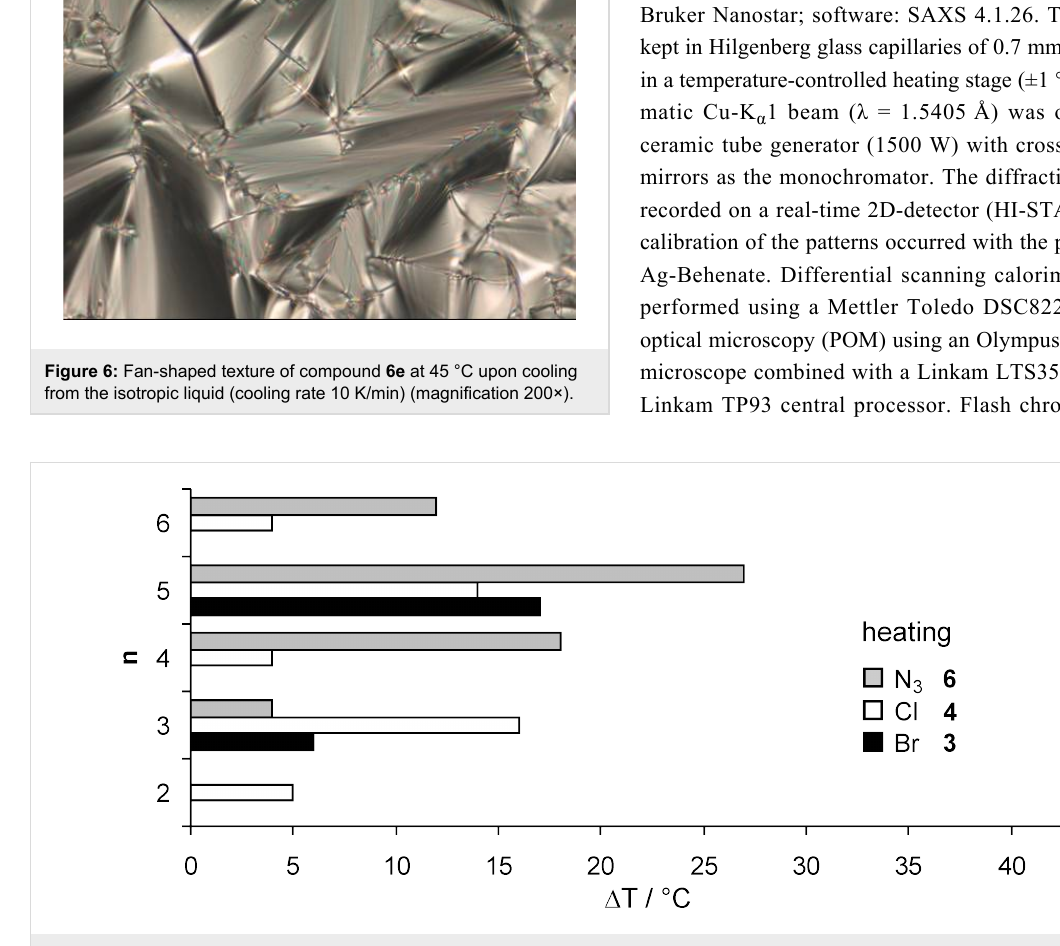
Figure 7: Comparison of the mesophase range Δ T for the different spacer lengths of compounds 3 , 4 and 6 : mesophase range upon heating (heating rate 10 K/min).